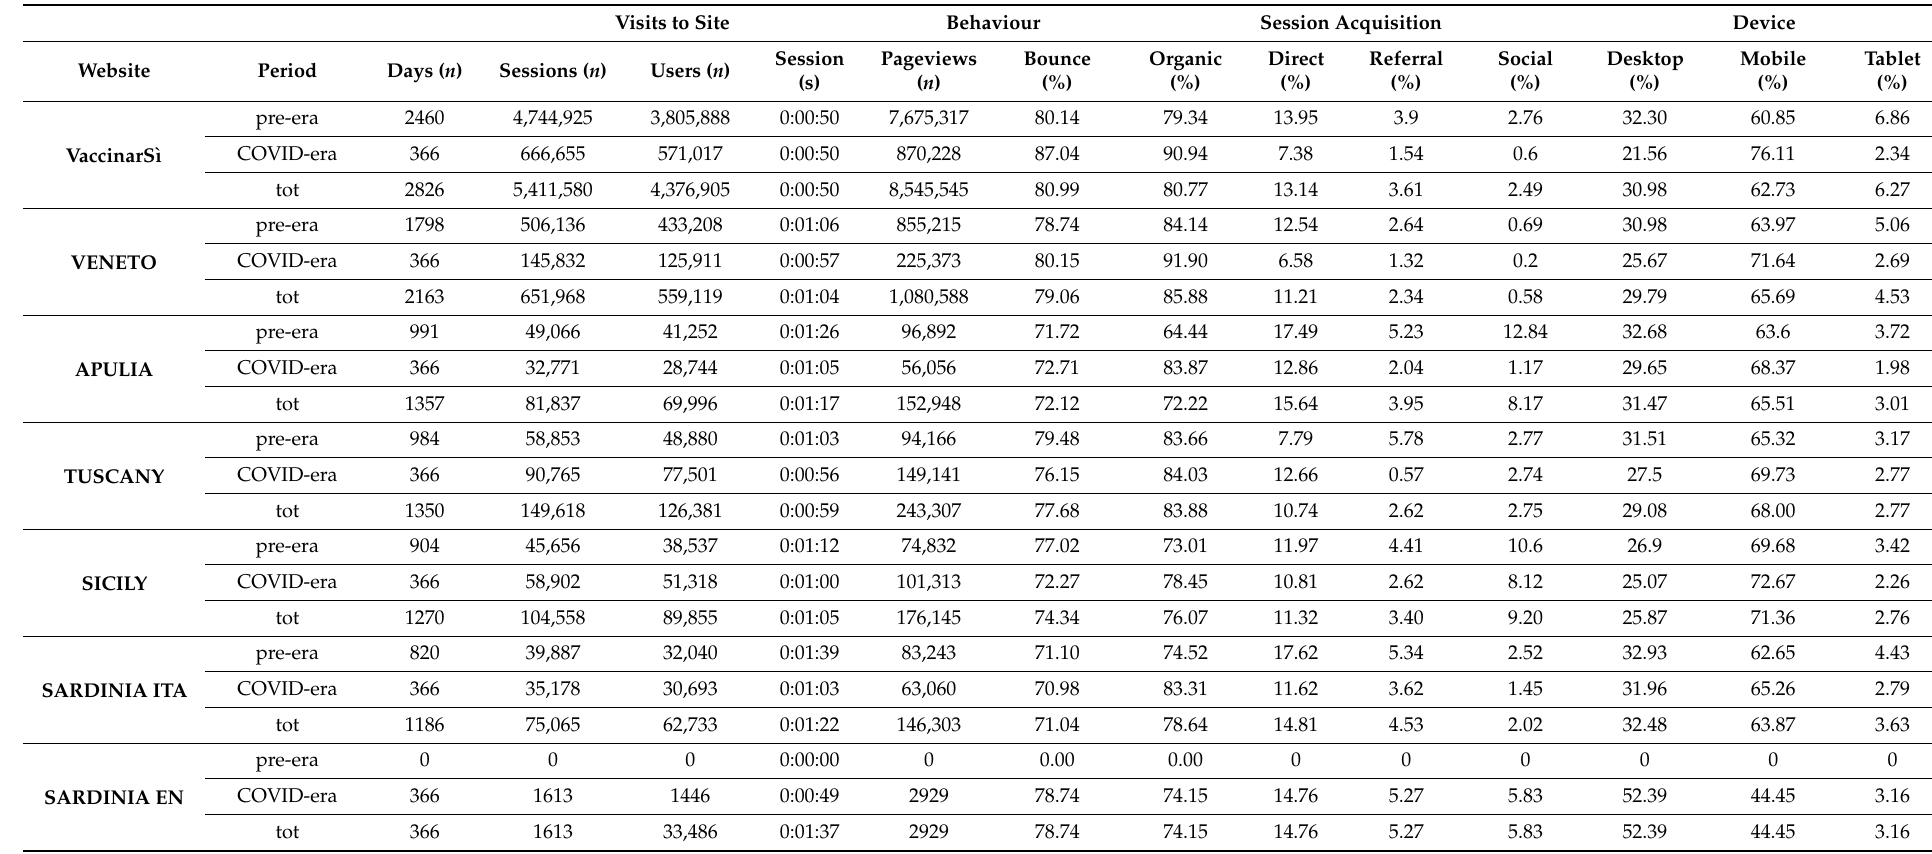
Table 2. Metrics for the VaccinarS ì network websites in the pre-COVID-19 era (from publication date to 31 January 2020); during the COVID-19 era (from 1 February 2020 to 31 January 2021) and the total (from publication date of each portal until 31 January